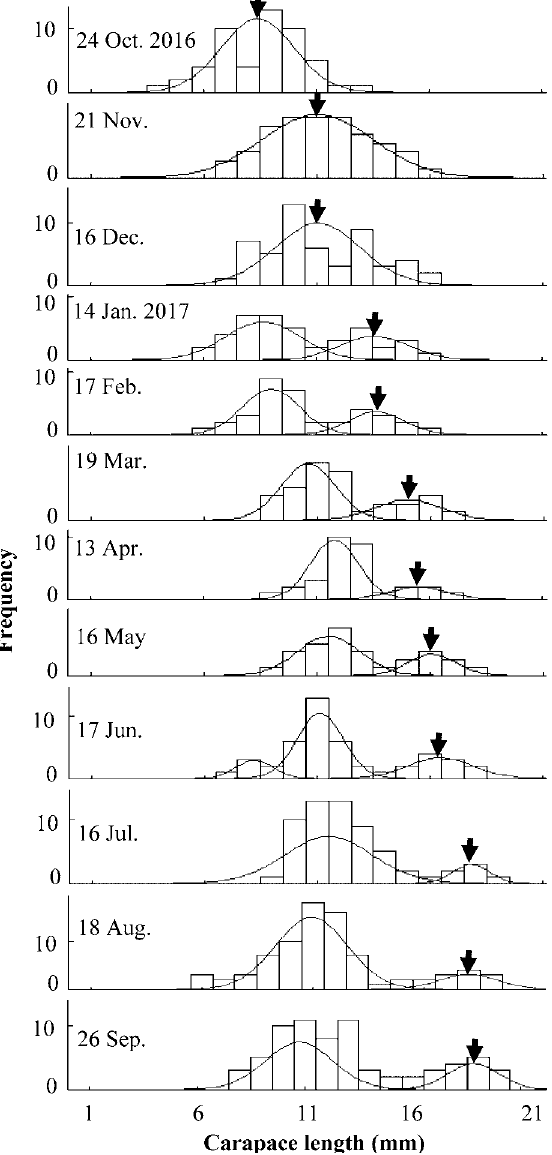
Figure 2. Length-frequency distributions of male Macrobrachium lamarrei collected from a wetland, northeastern Bangladesh during October 2016 to September 2017. Curves show the normal distributions, and arrows trace the progress of the